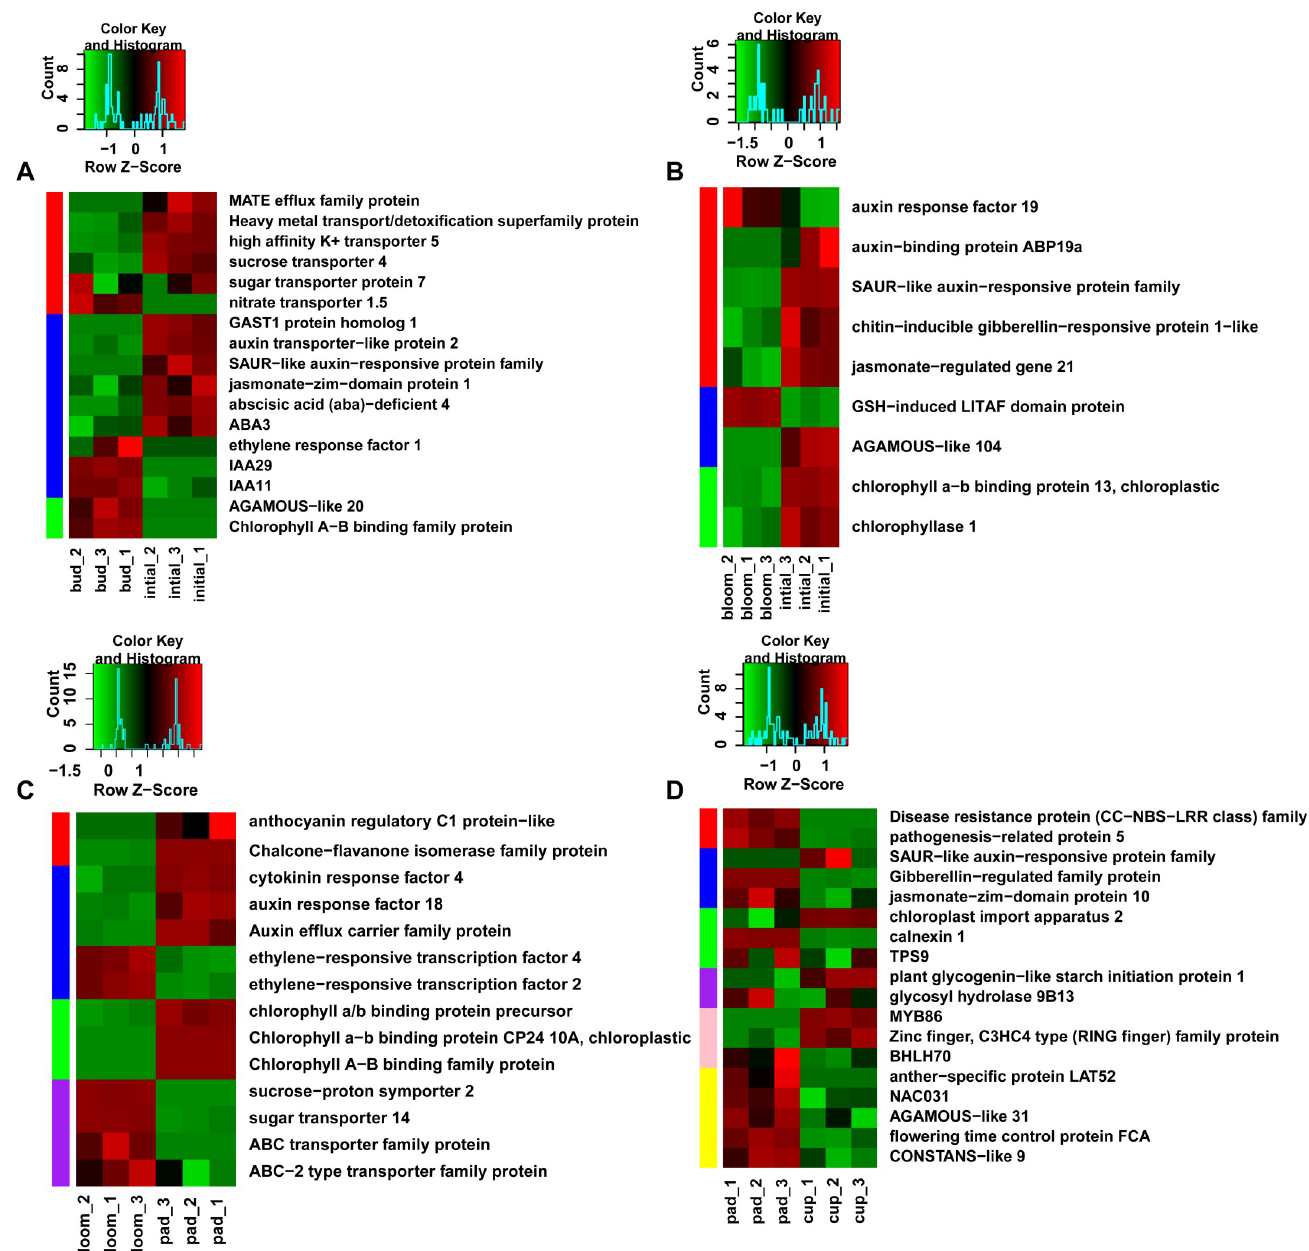
Fig 4. Gene expression profiles of differentially expressed genes in four comparisons. (A) S3/S2; (B) S4/S3; (C) S5/S4; (D) S6/S5. S2, S3, S4, S5, and S6 represent flower bud, initial flower, bloom flower, pad fruit, and cup fruit, respectively. Green represents genes down-regulated and red represents genes up-regulated. The abbreviations and full names of the genes involved are shown below: HAK5 ( high affinity K+ transporter 5 ), MATE ( multidrug and toxic compound extrusion efflux family protein efflux family protein ), SUT4 ( sucrose transporter 4) , STP7 ( sugar transporter protein 7 ), NRT1 . 5 ( nitrate transporter 1 . 5 ), GASA1 ( GAST1 protein homolog 1 ), AUX2 ( auxin transporter−like protein 2 ), JAZ1 ( jasmonate−zim−domain protein 1 ), ABA4 ( abscisic acid ( aba ) −deficient 4 ), ABA3 ( molybdenum cofactor sulfurase ( LOS5 )), ERF1 ( ethylene response factor 1 ), IAA29 ( indole-3-acetic acid inducible 29 ), IAA11 ( indole-3-acetic acid inducible 11 ), AGL20 ( AGAMOUS−like 20 ), CAB ( chlorophyll A−B binding family protein ), ARF19 ( auxin response factor 19 ), ABP19A ( auxin−binding protein ABP19a ), JRG21 ( jasmonate−regulated gene 21 ), GILP ( GSH−induced LITAF domain protein ), AGL104 ( AGAMOUS−like 104 ), CLH1 ( chlorophyllase 1 ), CHI ( chalcone−flavanone isomerase family protein ), CRF4 ( cytokinin response factor 4 ), ARF18 ( auxin response factor 18 ), ERF4 ( ethylene−responsive transcription factor 4 ), ERF2 ( ethylene −responsive transcription factor 2 ), CAB-10A ( chlorophyll a−b binding protein CP24 10A , chloroplastic), SUC2 ( sucrose−proton symporter 2 ), STP14 ( sugar transporter 14 ), ABC ( ABC transporter family protein ), ABCG4 ( ABC−2 type transporter family protein ), PR5 ( pathogenesis−related protein 5 ), JAZ10 ( jasmonate- zim-domain protein 10 ), CIA2 ( chloroplast import apparatus 2 ), CNX1 ( calnexin 1 ), TPS9 ( trehalose-phosphatase/synthase 9 ), PGSIP1 ( plant glycogenin−like starch initiation protein 1 ), GH9B13 ( glycosyl hydrolase 9B13 ), MYB86 ( myb domain protein 86 ), BHLH70 ( basic helix-loop-helix 70 ), LAT52 ( anther−specific protein LAT52 ), NAC031 ( Protein CUP-SHAPED COTYLEDON 3 ), AGL31 ( AGAMOUS−like 31 ), FCA ( flowering time control protein FCA ), COL9 ( CONSTANS−like 9 ).